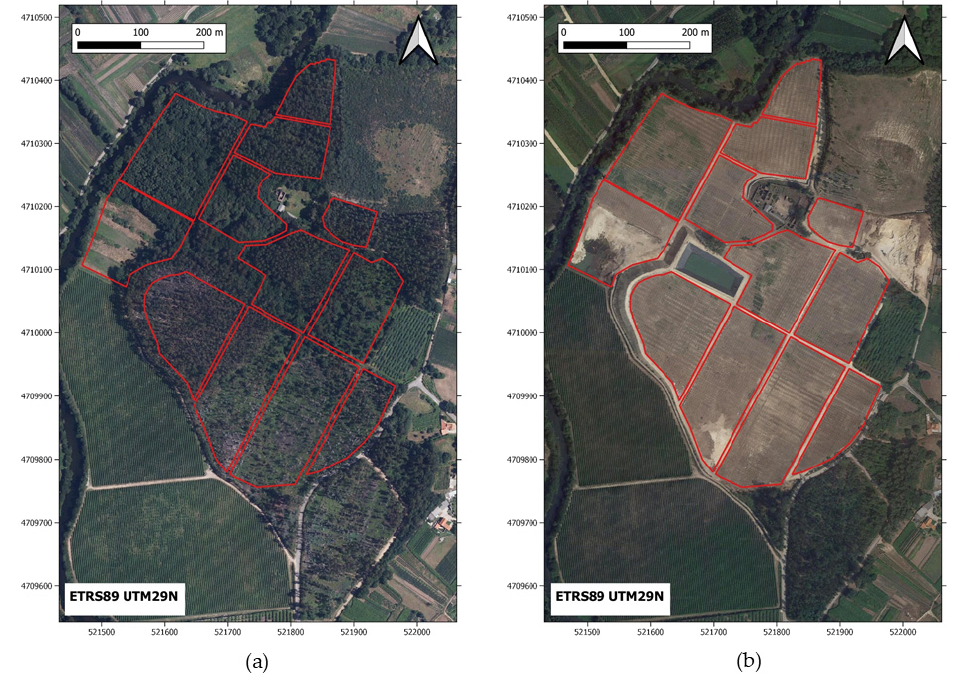
Figure 1. Study area before and after the works of land movement for the establishment of the vineyard: ( a ) 27 June 2007; ( b ) 19 August 2018 (Source: Google Earth). Polygons in red indicate the 12 sectors in which the vineyard has been divided.